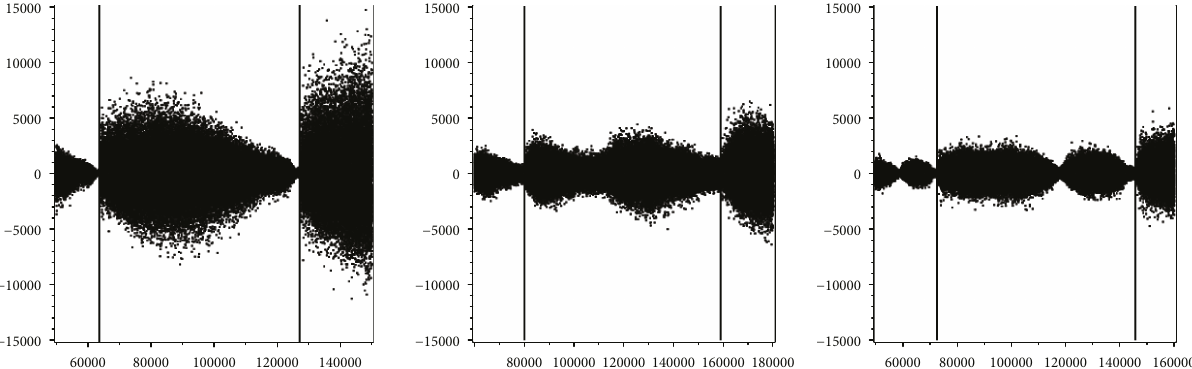
Figure 4: Illustrations of P